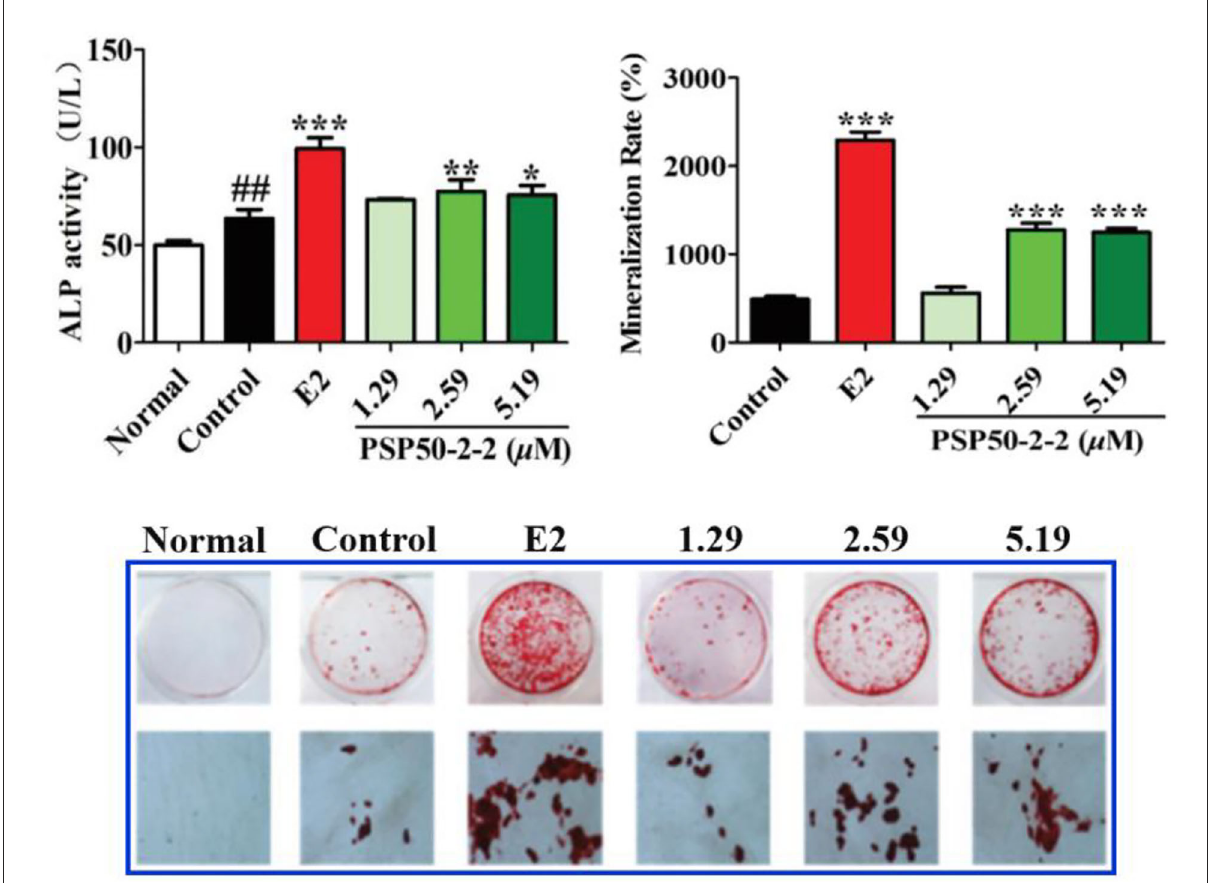
FIGURE5 Effects of PSP50-2-2 fraction on the mineralization of MC3T3-E1 cells evidenced by the ALP activity, mineralization rate, and image of MC3T3-E1 cells. Images show alizarin red S staining of MC3T3-E1 cells treated with different concentrations of PSP50-2-2 (15). Copyright 2021, Royal Society of